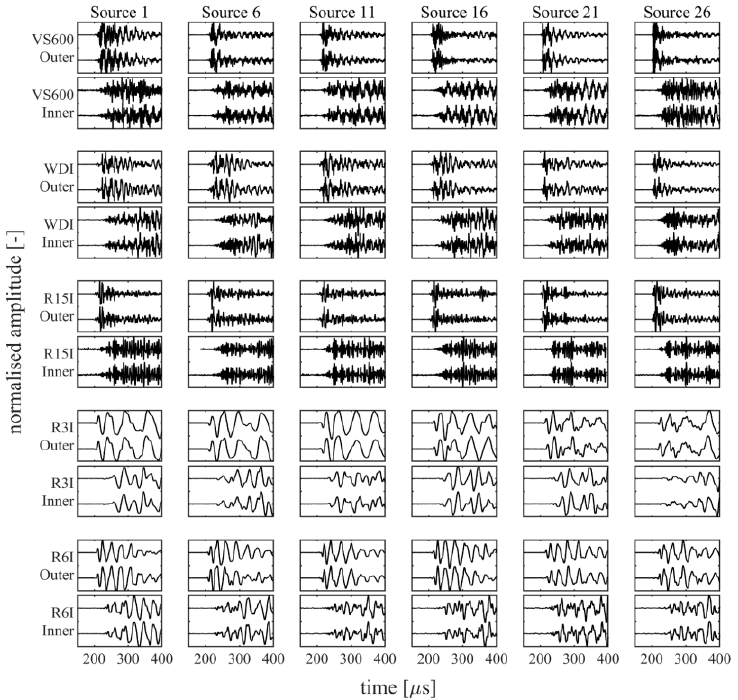
Figure 4. Overview of the recorded waveforms for several outer raceway sources. Each block depicts a 250 µs sample of two waveforms that have been normalised with their respective peak amplitudes.